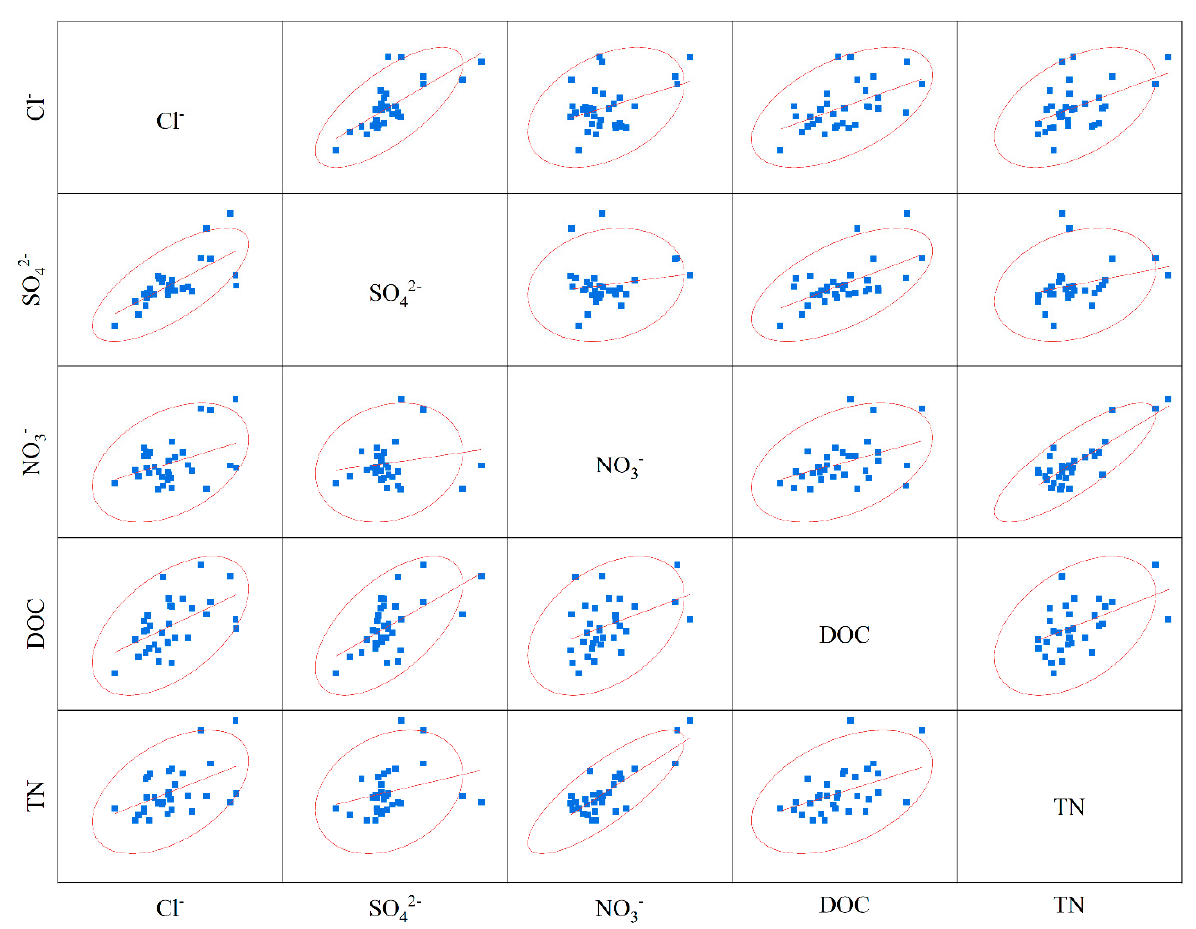
Figure 9. C, N, and ion correlation.